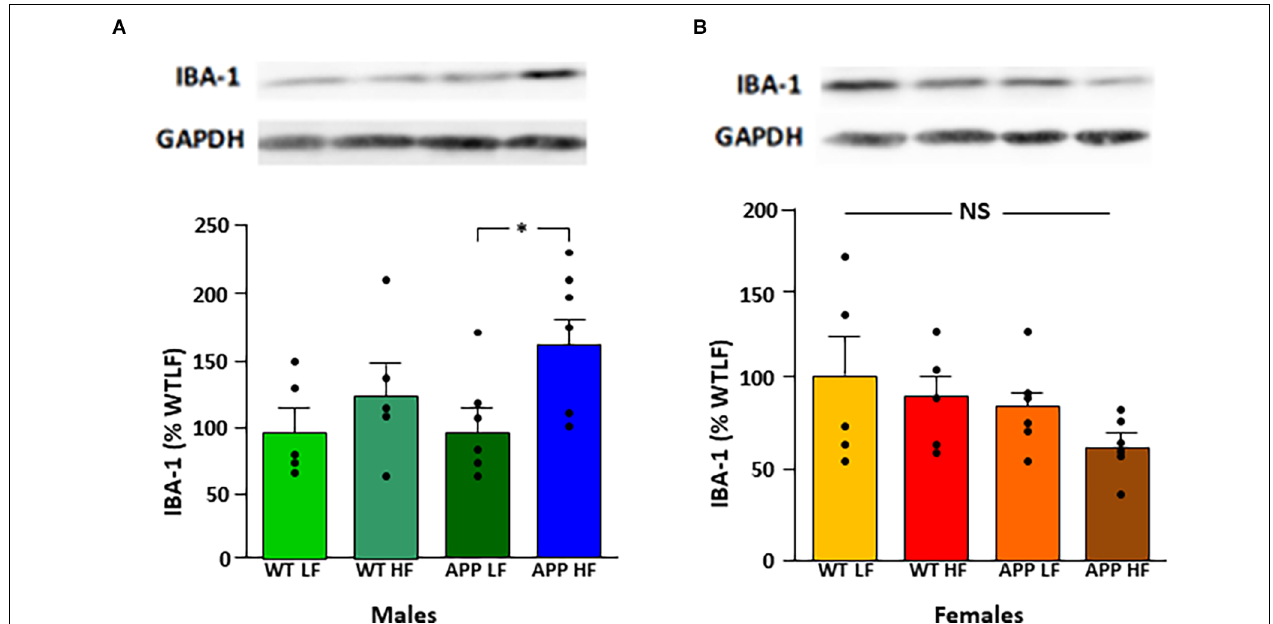
FIGURE 7 | Relative protein levels of ionized calcium binding adaptor molecule 1 (Iba-1) in the hypothalamus of male (A) and female (B) mice after being exposed to a low fat (LF) or high fat (HF) diet. Bar graphs represent the mean ± SEM 5–6 mice per experimental group. Samples from males and females were analyzed separately and are thus not directly compared. WT, wild type; APP, transgenic for amyloid precursor protein; GAPDH, glyceraldehyde 3-phosphate dehydrogenase; NS,